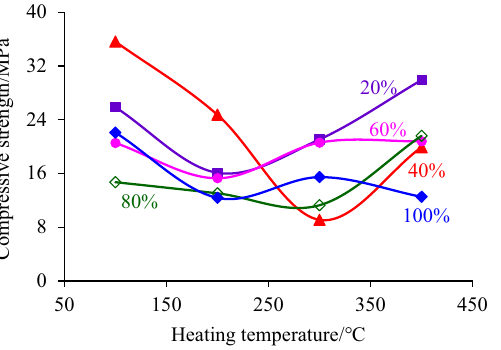
Figure 6. The change rule of compression strength with the heating temperature increasing.